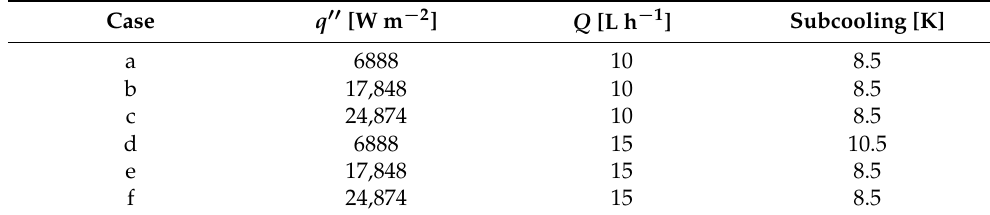
Table 2. Available experimental